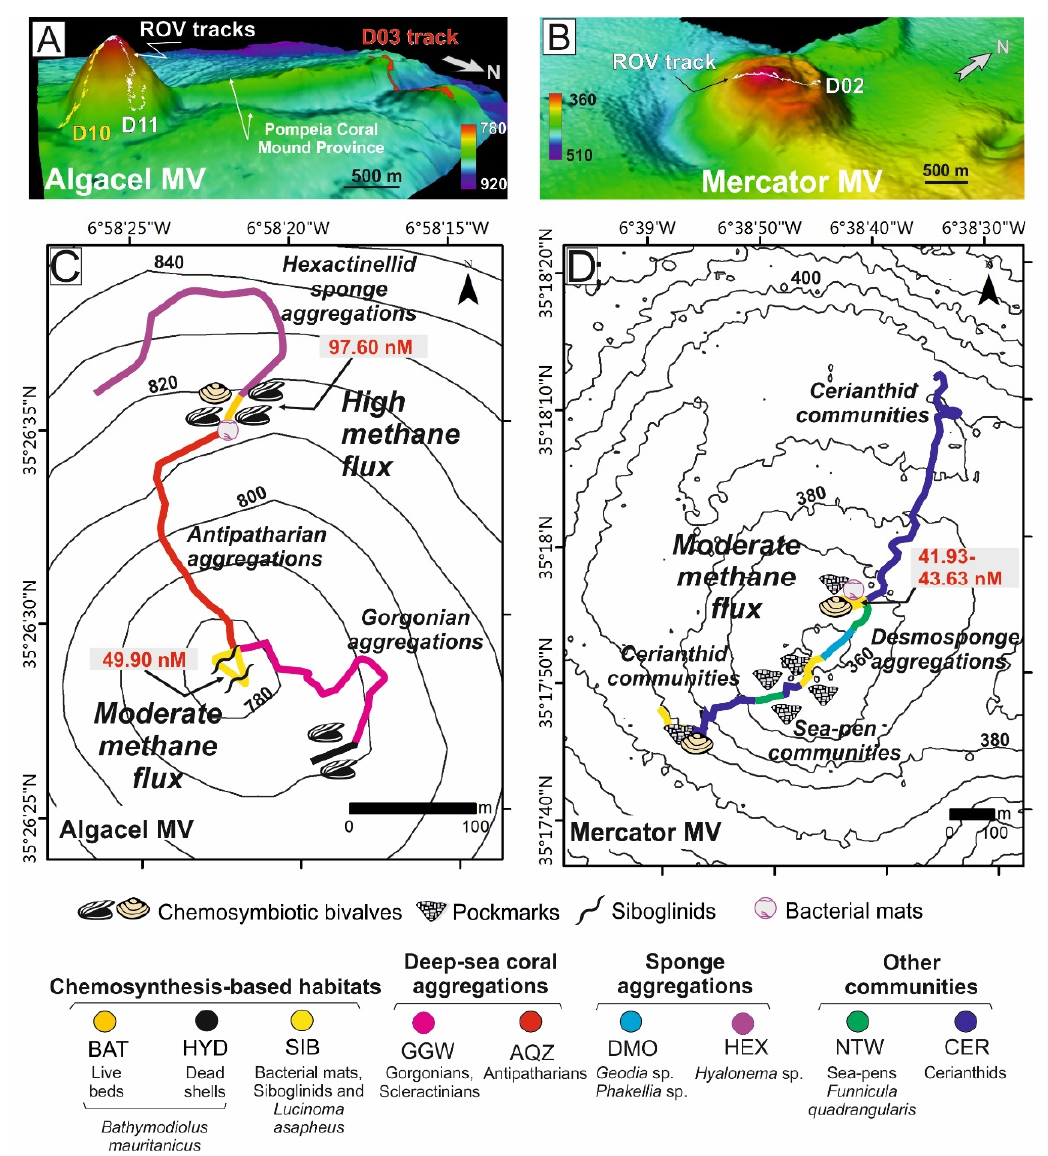
Figure 5. Vulnerable deep-sea habitats in mud volcanoes (MVs) of the Moroccan margin (Gulf of Cádiz). ( A , B ) 3D models of the Algacel and Mercator MVs as well as the Northern Pompeia Coral Ridge at the Pompeia Coral Mound Province, where ROV dives were carried out. Distribution of deep-sea habitats and organisms across ( C ) Algacel and ( D ) Mercator MVs. Methane concentrations are displayed in red letters. Location of MVs in Figure 4A. See further explanation in the text.